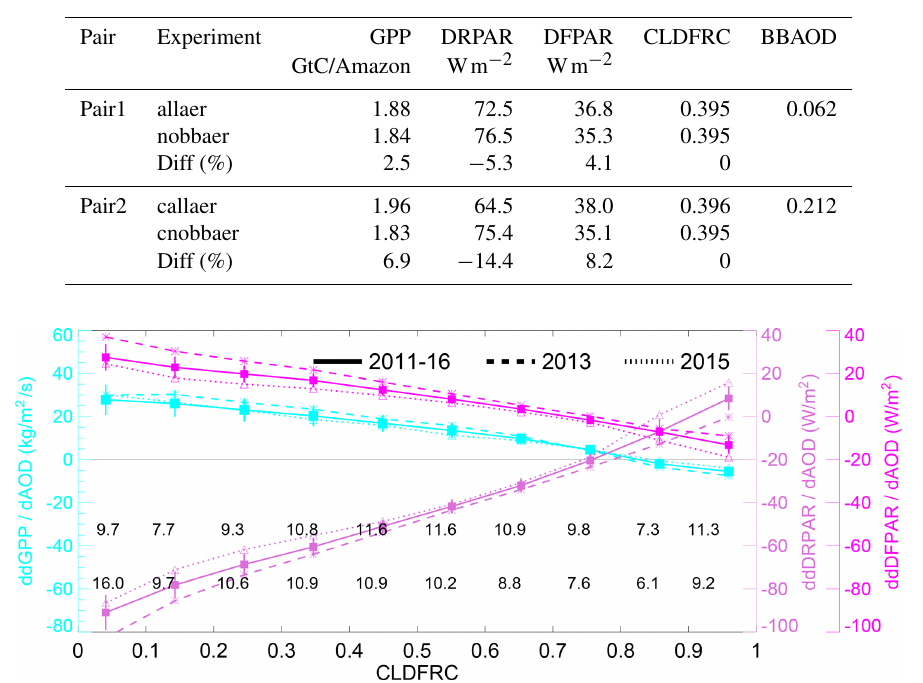
Table 3. Summary of mean GPP, DRPAR, DFPAR, CLDFRC, and BBAOD over August–September of 2011–2016, as well as the relative changes in GPP, DRPAR, DFPAR, and CLDFRC within a pair of simulations.